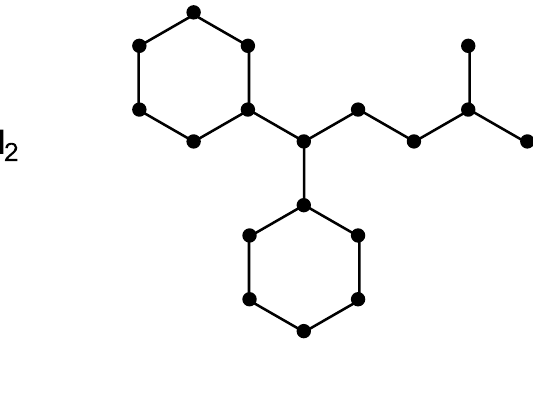
Figure 1. Abstract representation of a molecule as a mathematical graph. Topological properties of molecules are typically derived from a hydrogen-supressed representation by reducing molecules to their connectivity information and disregarding atom type and bond